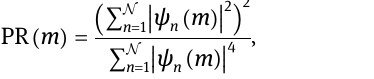
We plot in Figure 2 the polariton dispersion of Eq. (11) for the cavity heights L x (cid:1) { 5 a , 10 a , 15 a } in panels (a), (b), and (c) respectively, where the cavity aspect ratio is fi xed at L L d = 3 a . With y = 3 x and the interdipole separation at increasing cavity cross-sectional area in going from panel (a) to (b) to (c), the light – matter detuning Δ q is reduced (cf. Eq. (12)), leading to increasingly noticeable deviations of the polariton bands (solid lines) from the uncoupled dis- persions (dashed lines). The upper (lower) polariton band is given by the red (blue) lines. The photonic bandstructure is denoted by orange lines, while the dipolar bands are in cyan. Notably, in panel (a), only a single polaritonic band is visible on this scale since the (mostly photonic) upper polariton band lies signi fi cantly above the frequency scale of ω 0 . Panel (b) demonstrates the strong coupling regime and its associated highly reconstructed polariton disper- sion, while panel (c) displays the usual band anticrossing behavior as the detuning is further reduced. The Bogoliubov operators of Eq. (13) imply the pair of polaritonic Bloch spinors ψ q + (cid:1) ( sin θ q , − i cos θ q ) T and (cid:1) ( cos θ , i sin θ ) T . Notably, unlike the celebrated ψ q q q − spinors describing excitations in some topologically phase factor difference (like e i δ q ) between the upper and lower components of each individual spinor ψ q τ . This